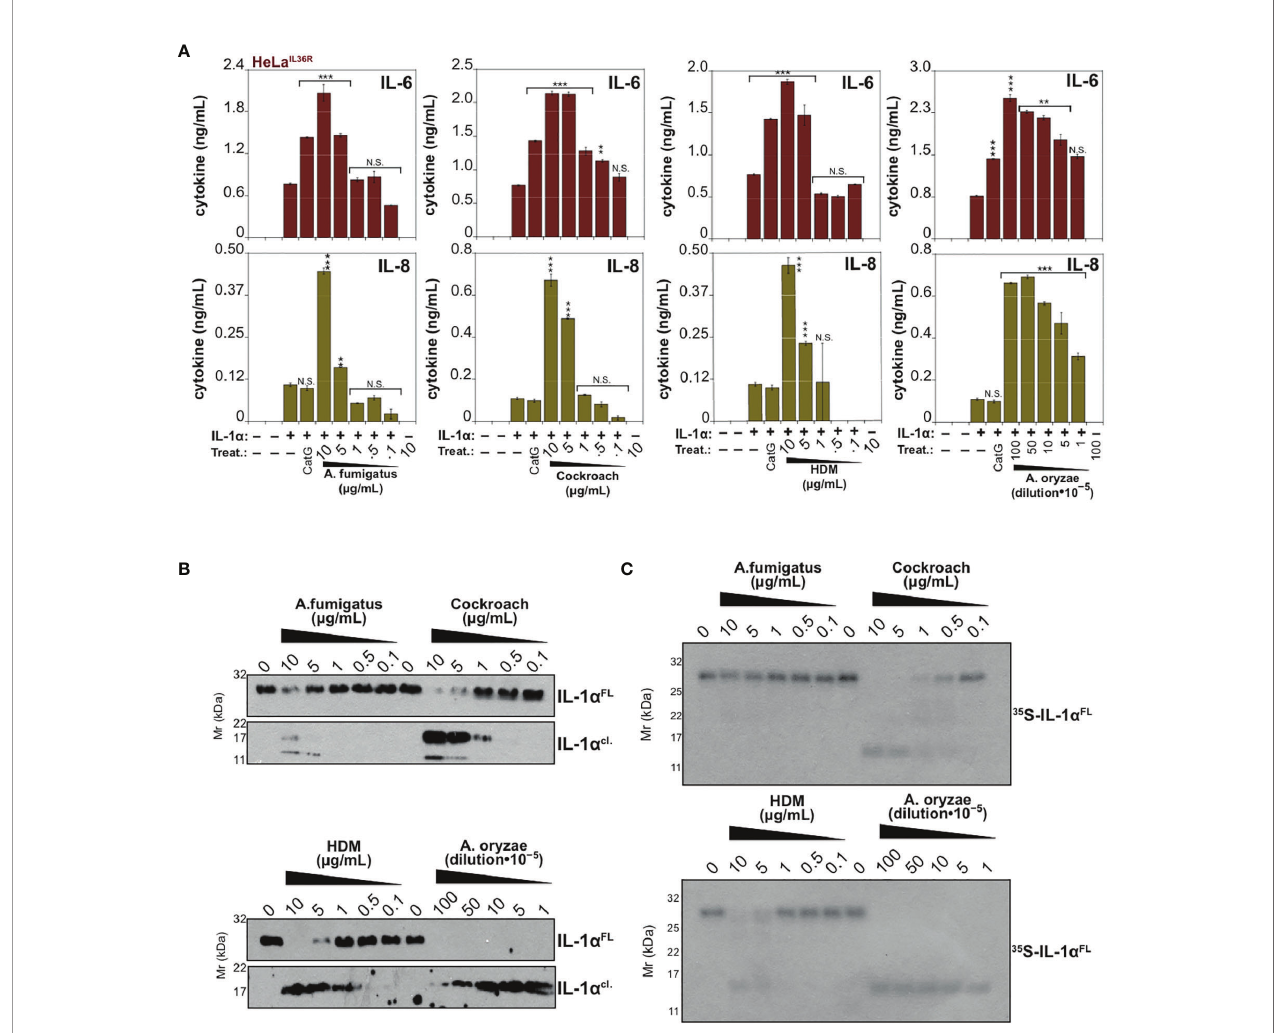
FIGURE 5 | IL-1 a is processed and activated by proteases associated with Aspergillus fumigatus , cockroach, house dust mite and Aspergillus oryzae (A) HeLa IL-36R cells were stimulated with full-length human IL-1 a (2 nM), either untreated, or after incubation for 2 h at 37°C with the indicated concentrations of allergen extracts. As a positive control, IL-1 a , was activated with 50 nM Cathepsin G. After 24h, IL-6 and IL-8 cytokine concentrations in cell culture supernatants were measured by ELISA. (B) Recombinant full-length human IL-1 a (200 nM per reaction) was incubated for 2 h at 37°C in the presence or absence of a range of concentrations of the indicated allergens, followed by assessment of proteolysis by immunoblotting. (C) 35 S-labeled in vitro transcribed/translated human IL-1 a was incubated for 2 h at 37°C either alone or with the indicated allergen extracts, followed by SDS-PAGE and fl uorography. Error bars represent the mean of triplicate determinations from representative experiments. ***p < 0.001, **p < 0.01, *p < 0.1, Student ’ s t test. N.S., Not Signi fi